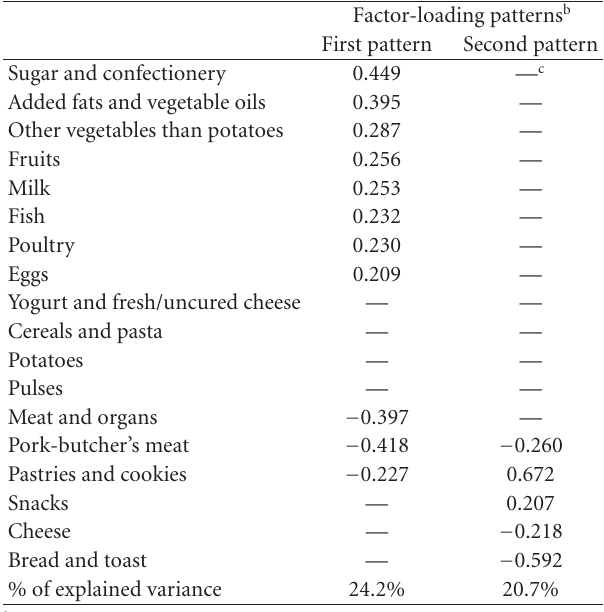
Table 2: Factor-loading matrix for the major factors (diet pattern) identified by using food group intakes a